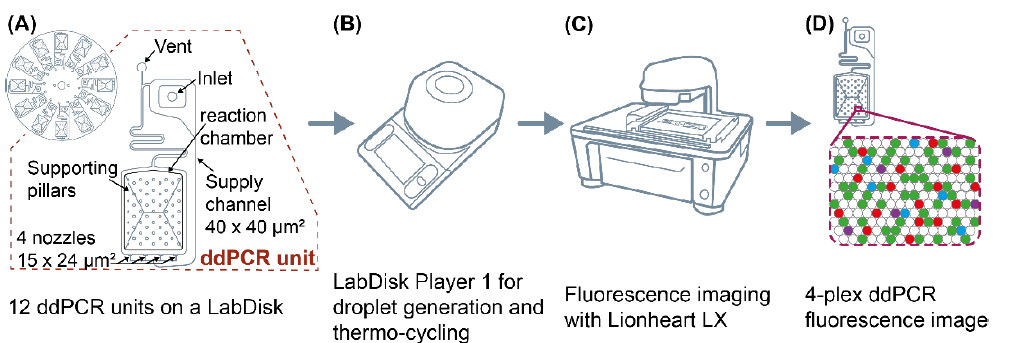
Figure 1. Workflow for an automated four-plex digital droplet polymerase chain reaction (ddPCR) in a LabDisk. ( A ) LabDisk with 12 identical ddPCR units. Each unit consisted of an inlet, a venting structure, a supply channel, a reaction chamber with supporting pillars and four nozzles for droplet generation by centrifugal step emulsification. ( B ) Droplet generation and thermocycling in LabDisk Player 1. ( C ) Fluorescence imaging with an automated Lionheart LX fluorescence microscope. ( D ) Four-plex ddPCR fluorescence image and data evaluation with Gen5 software to evaluate the assay performance.